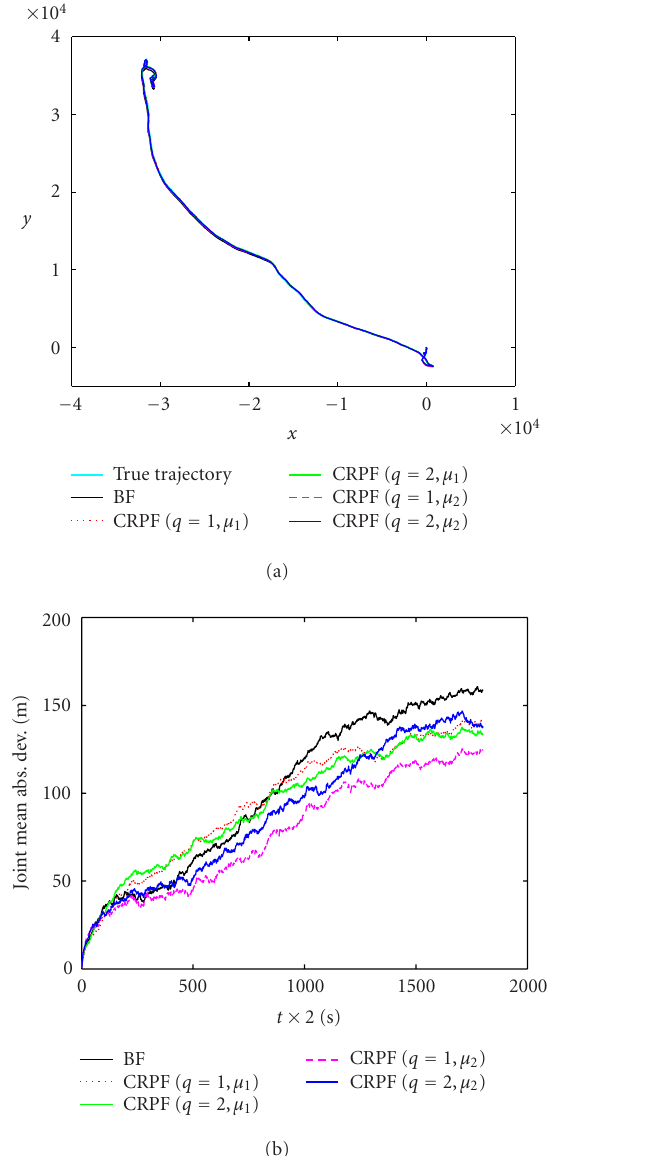
Figure 2: Mixture Gaussian noise processes. T s = 2 seconds. (a) Trajectory. (b) Mean absolute deviation.